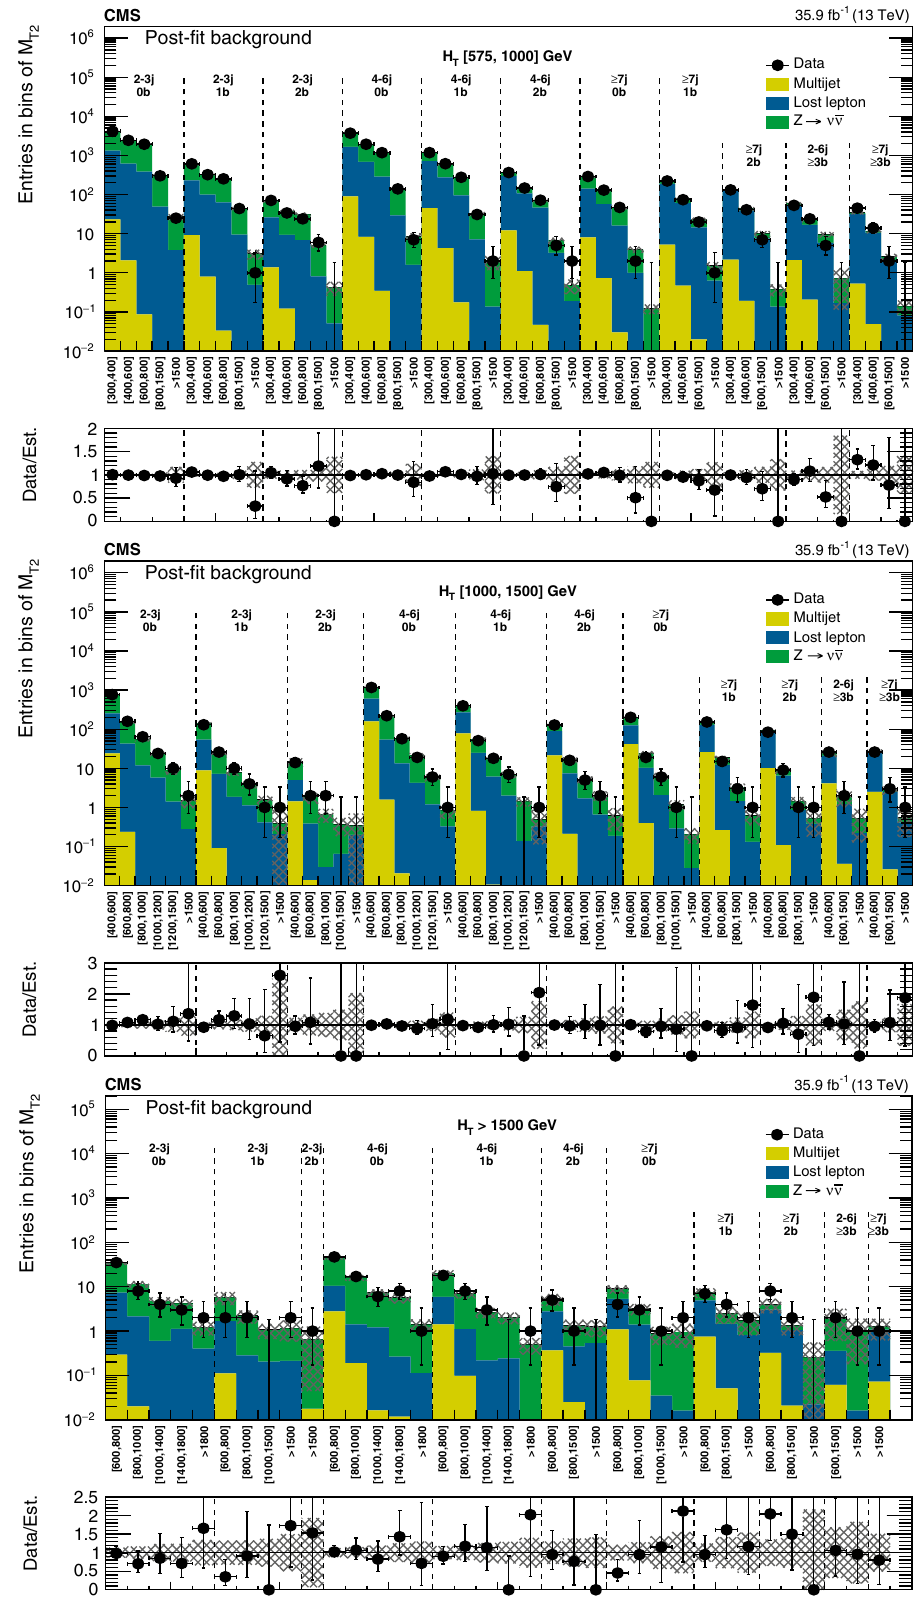
Fig. 13 (Upper) Comparison of the post-fit background prediction and observed data events in each signal bin in the medium- H T region. Same for the high- (middle) and extreme- (lower) H T regions. On the x -axis, the M T2 binning is shown in units of GeV. The hatched bands represent the post-fit uncertainty in the background prediction. For the extreme- H T region, the last bin is left empty for visualization